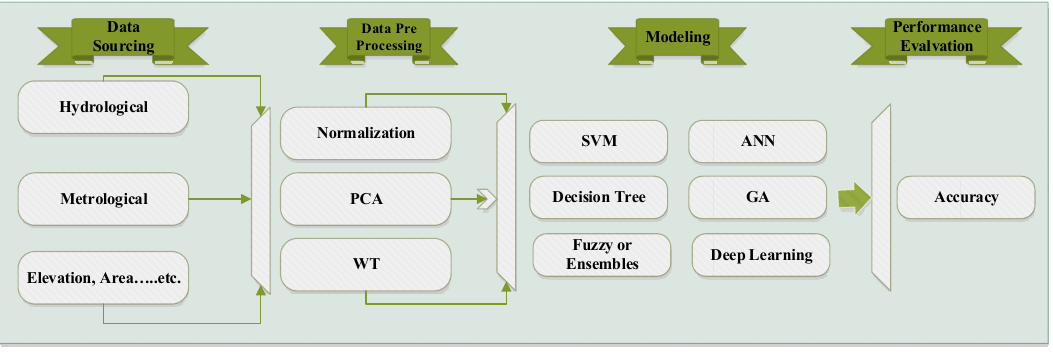
Figure 3. Groundwater prediction process.